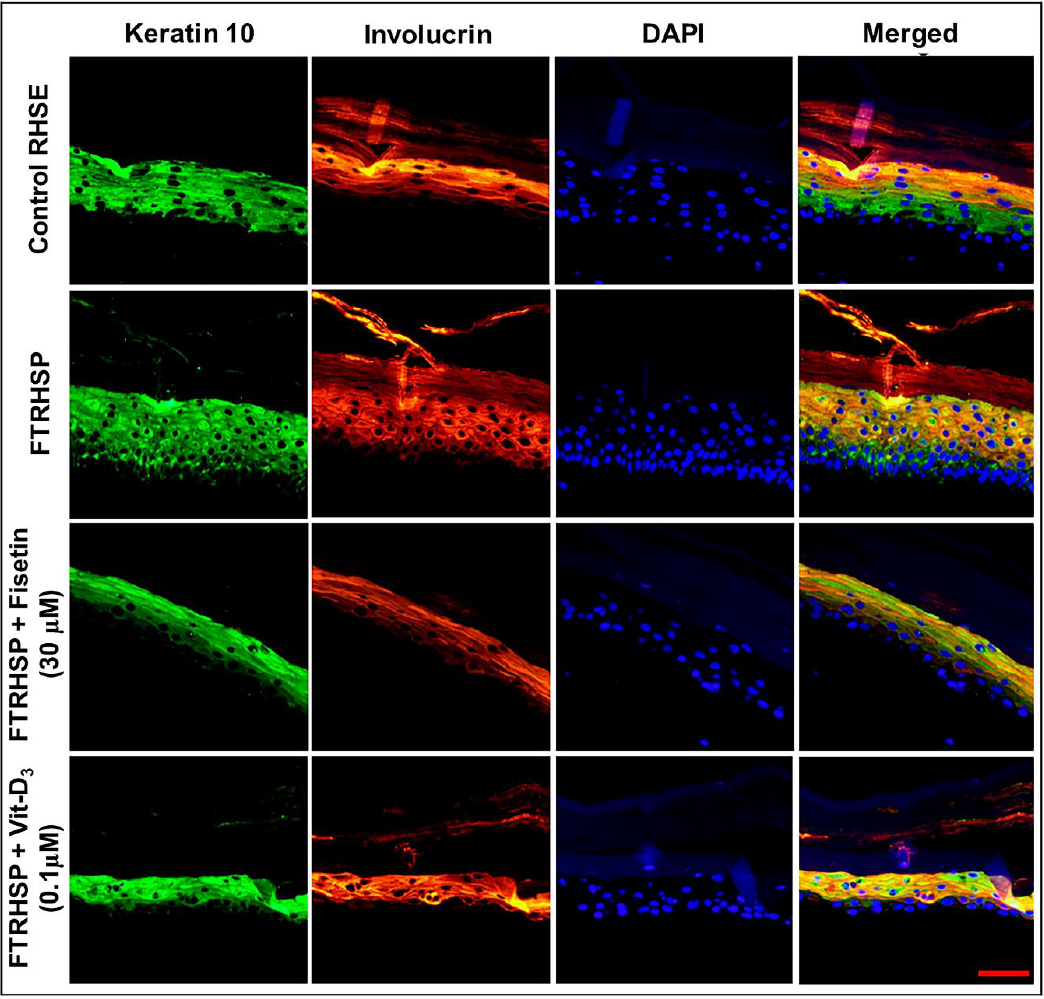
Figure 8. Fisetin modulates psoriasis-like features in the 3D full-thickness reconstituted human skin model of psoriasis (FTRHSP). Immunofluorescence staining was performed on FTRHSP sections by incubating with primary antibody against targets overnight at 4 °C followed by incubation with specific Alexa Flour 488-labeled secondary antibodies for 2 h at room temperature in the dark. Samples